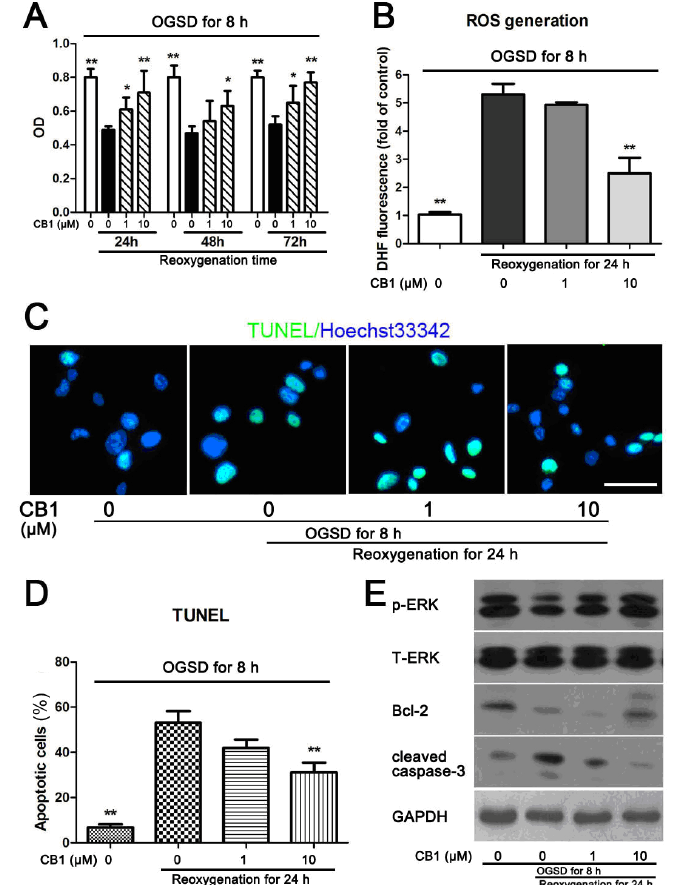
Figure 2. ( A ) Effect of cinnamtannin B-1 (CB1) on the viability of astrocytes. After 14 days culture, the astrocytes were subjected to oxygen-glucose-serum deprivation (OGSD) for 8 h, followed with/without reperfusion for 24, 48, 72 h in the absence or presence of 1 and 10 μ M cinnamtannin B-1. After treatment, MTT assay was performed and the optical density (OD) was measured at a wavelength of 490 nm. * p < 0.05 and ** p < 0.01 compared to vehicle-treated OGSD/reoxygenation group, respectively, n = 6; ( B ) Effect of CB1 on reactive oxygen species (ROS) generation. ROS level in each group was determined after OGSD 8 h following with/without reperfusion for 24 h. The fluorescence of dichlorofluorescein (DCF) was measured. * p < 0.05 and ** p < 0.01 compared to vehicle-treated OGSD/reoxygenation group, n = 3; ( C ) Terminal deoxynucleotidyl transferase dUTP nick end labeling (TUNEL) staining. TUNEL positive cells were marked with green fluorescence, and the nuclei of cells were stained blue by Hoechst 33342. The merged figures were shown and the scale bar = 50 μ m and referred to all panels; ( D ) The statistical analysis of TUNEL positive cells. ** p < 0.01 compared to vehicle-treated OGSD/reoxygenation group, n = 6; ( E ) Immunoblot analysis. Following OGSD for 8 h ensuing with/without reperfusion treatment for 24 h, the cell lysate from four groups were collected and immunoblot analysis of phosphorylation extracellular regulated protein kinase (p-ERK), total ERK (T-ERK), Bcl-2, cleaved caspase-3 and GAPDH were performed. Three independent experiments were performed and a representative experiment was